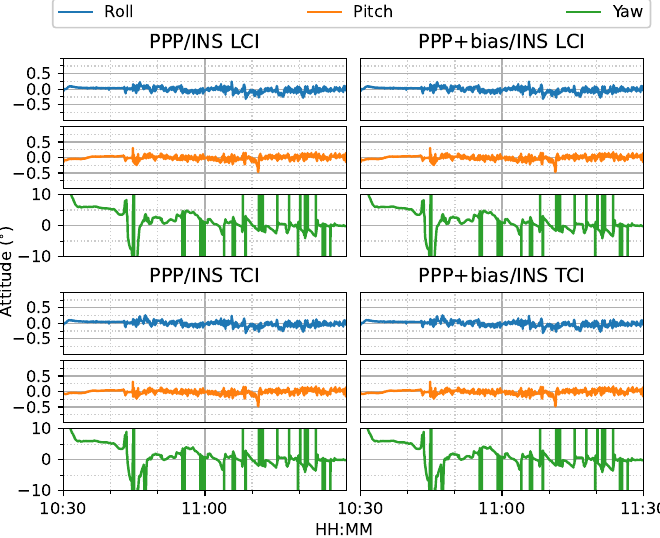
Figure 24. GPS/Galileo PPP/INS attitude results of road bridge test on 11 February 2022 with respect to IE RTK/INS TCI solutions.